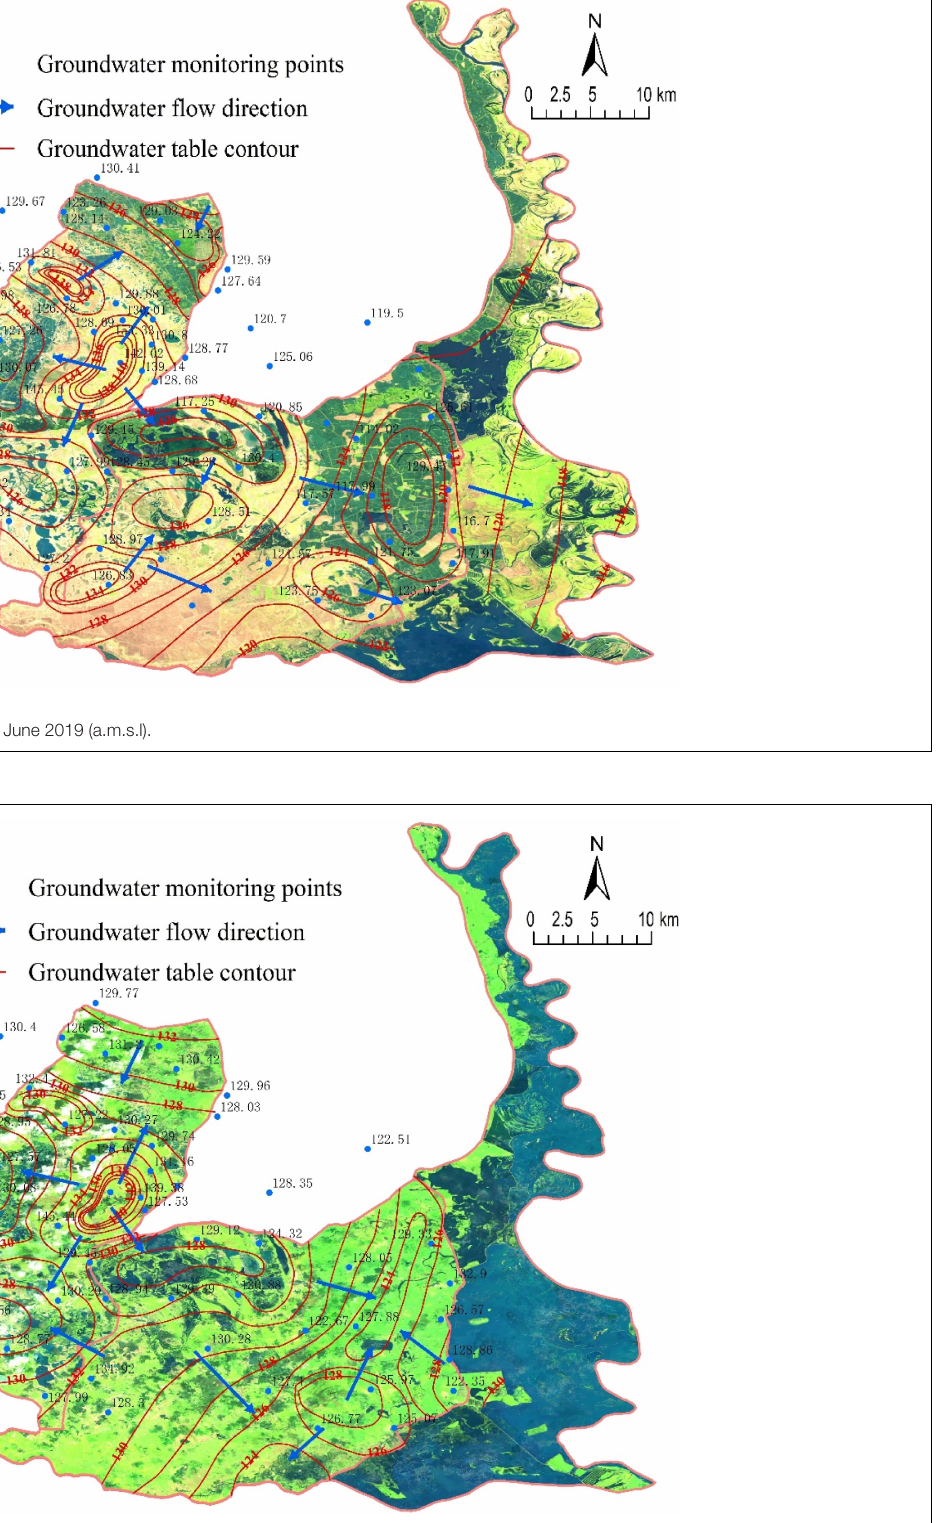
FIGURE 8 | Groundwater table contour in September 2019